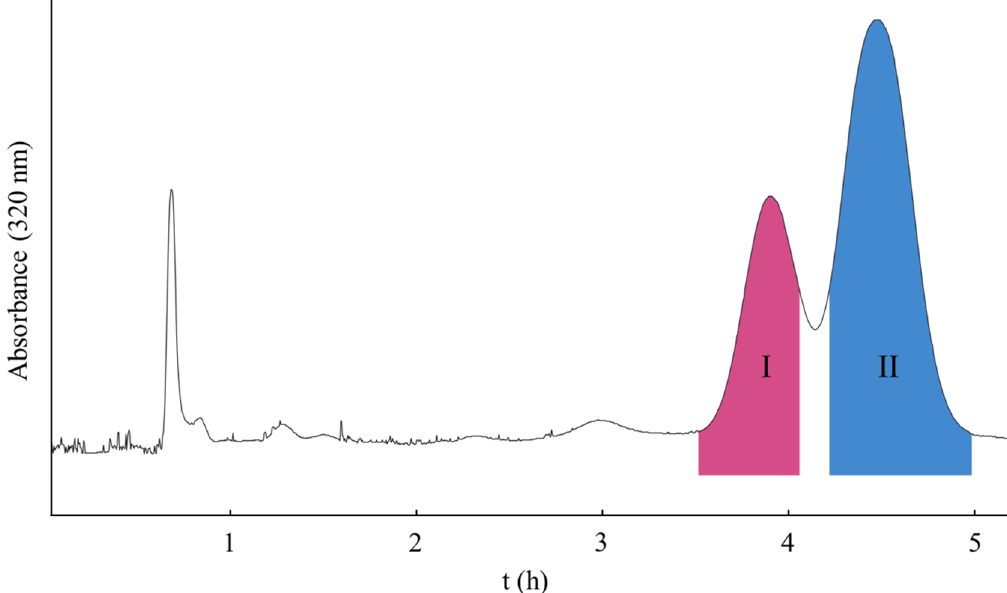
Figure 4. The off-line dimensional CCC procedure on the separation of peak III in Figure 2; solvent system: n -hexane/ethyl acetate/methanol/water (5:5:4:6, v / v ); flowrate: 2.0 mL/min; and detection wavelength: 320 nm.